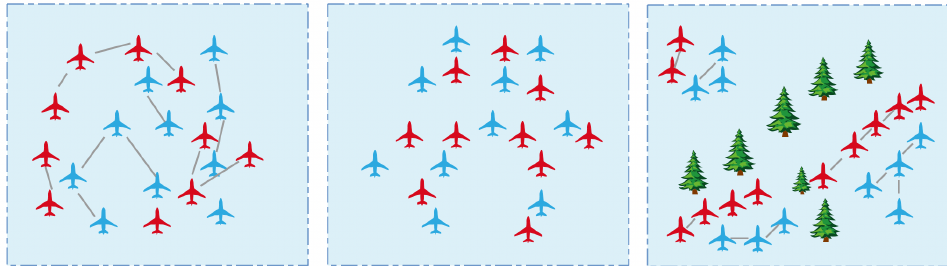
Figure 2. Three situations of swarm